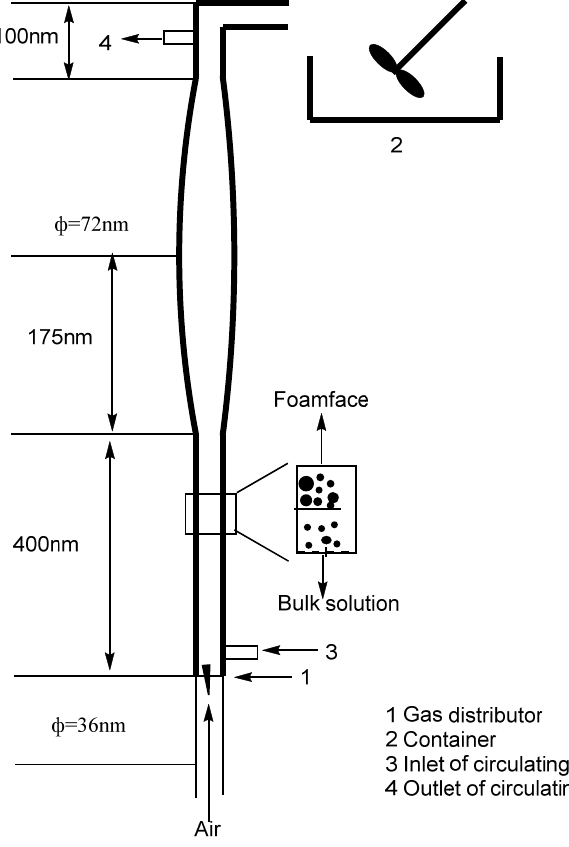
Figure 5. Experimental apparatus of foam fractionation [48].